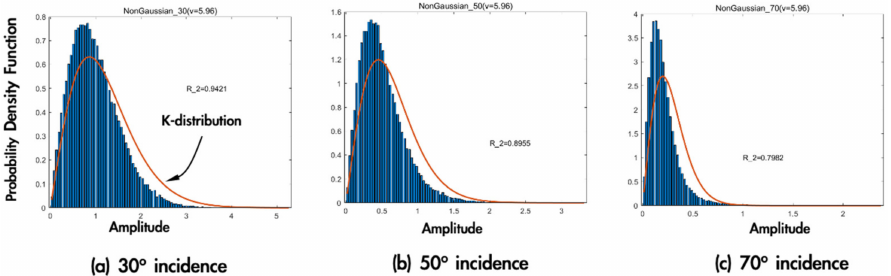
Figure 9. Comparison of PDF of speckle between simulated data and K distribution at incident angles of 30 ◦ ( a ), 50 ◦ ( b ), and 70 ◦ ( c ). The R 2 values for each case are shown. Surface parameters: Weibull HPD, exponential PSD with RMS height σ = 0.39 λ and correlation length (cid:96) = 1.56 λ